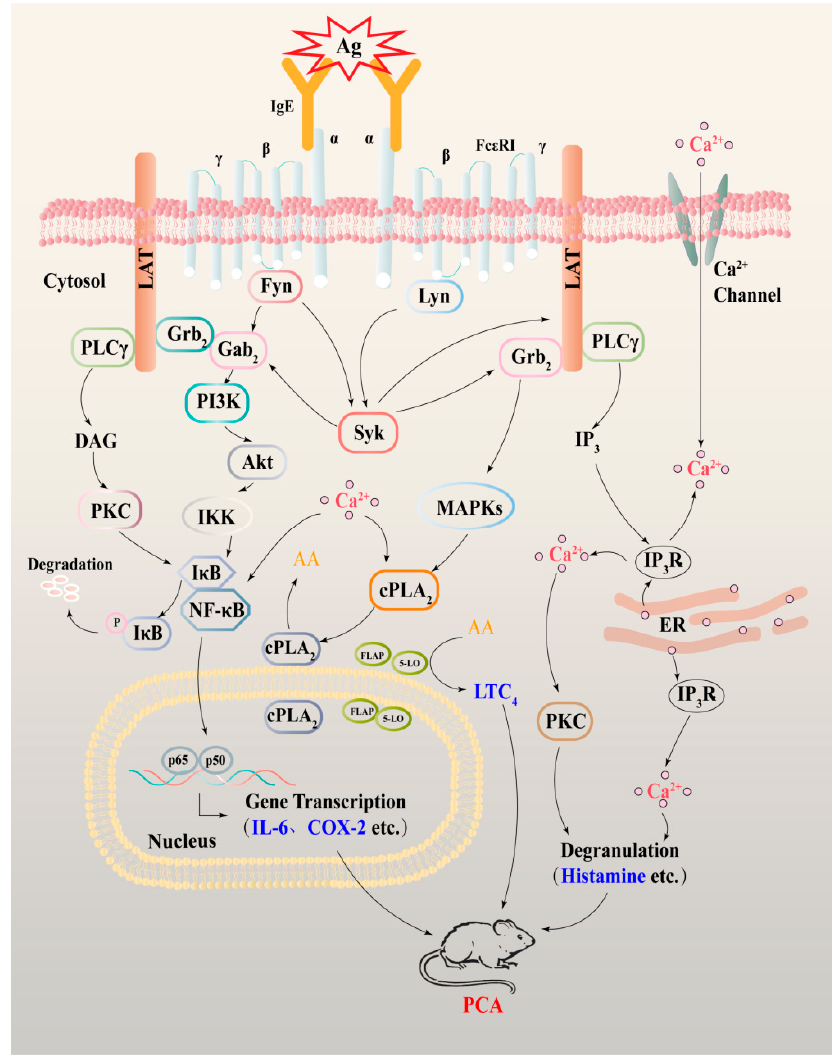
Figure 7. Schematic diagram describing the effect of AB23A on IgE/Ag-mediated mast cell activation and allergic PCA reaction.